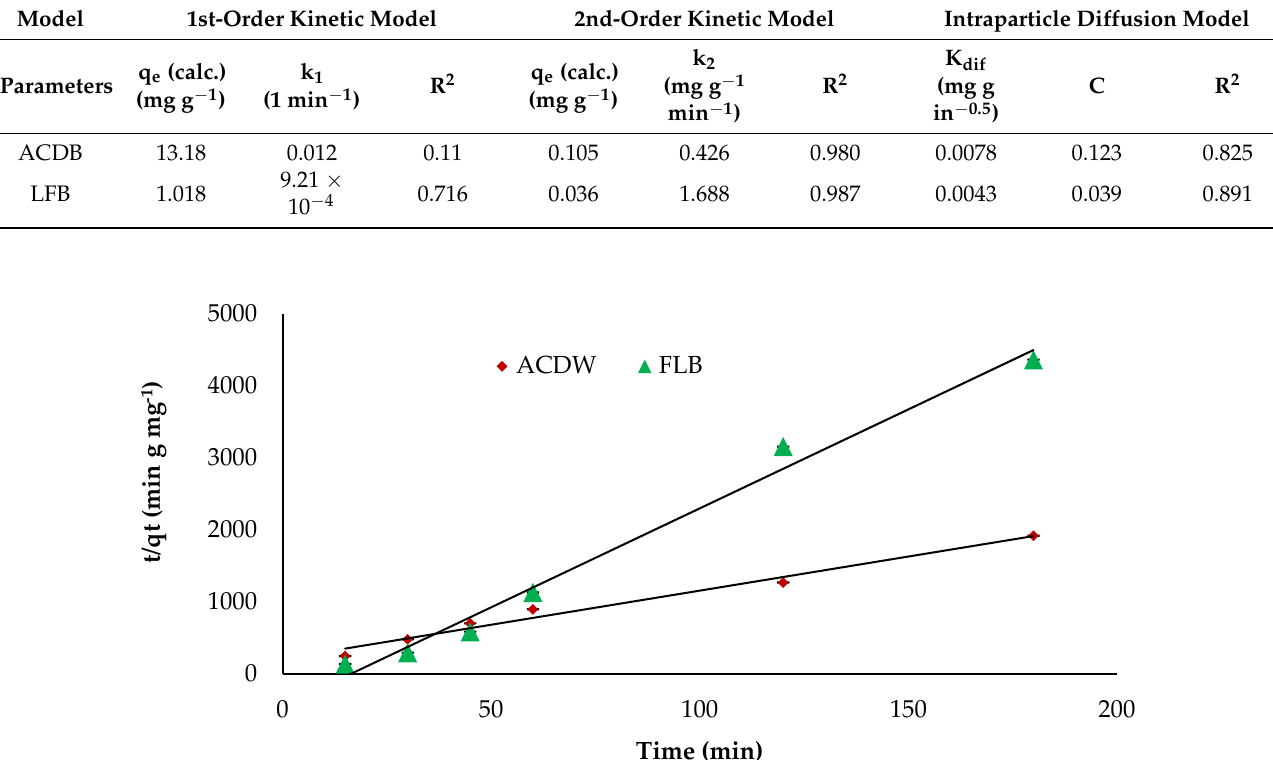
Figure 13. Intraparticle diffusion kinetics of IV2R dyes onto ACDB and LFB. Table 4. Comparison of the kinetic model for IV2R dyes from ACDB and LFB. Model